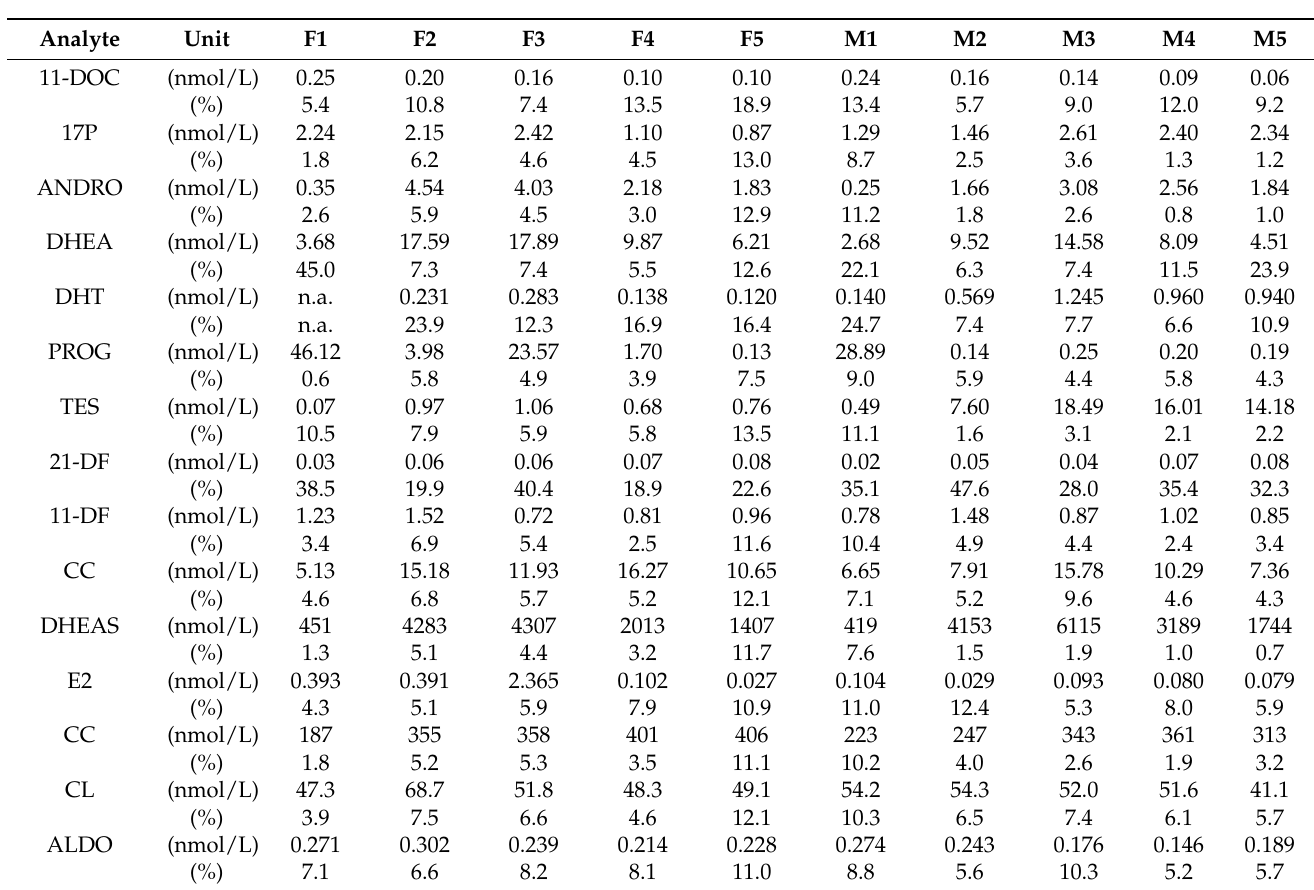
Table 2. Precision in pooled human serum samples of 11-deoxycorticosterone (11-DOC), 11- deoxycortisol (11-DF), 17-OH-progesterone (17P), 21-deoxycortisol (21-DF), androstenedione (ANDRO), aldosterone (ALDO), corticosterone (CC), cortisol (CL), cortisone (CN), dehydroepiandros- terone (DHEA), dehydroepiandrosterone sulfate (DHEAS), dihydrotestosterone (DHT), estradiol (E2), progesterone (PROG), and testosterone (TES). Serum pools are age- and gender-stratified. F and M are female and male samples, respectively. 1–5 are the age groups <10 years, 10–16 years, 16–45 years, 45–60 years, and >60 years,